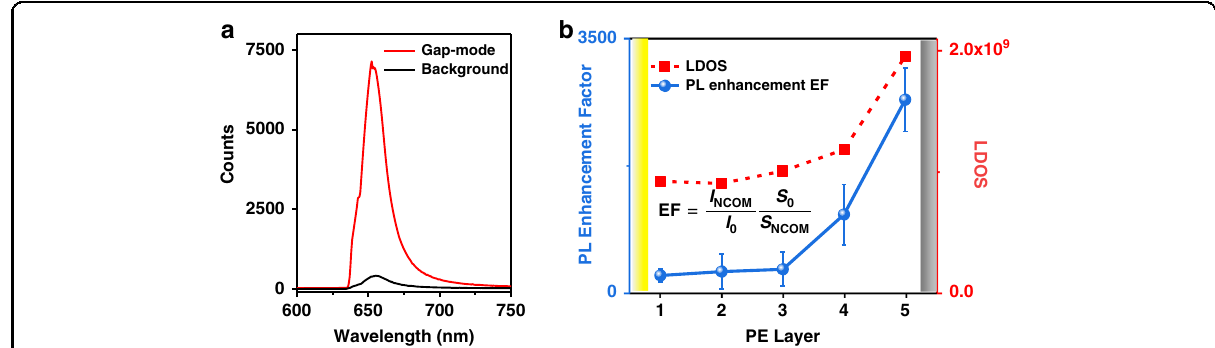
Fig. 4 The PL spectrum study of monolayer MoS 2 at the above gap-mode nanocavity with the same thickness of PE layers. a PL spectra of monolayer MoS 2 with (red) and without (black) gap-mode nanocavity. b The blue line is the enhancement factor of the PL at different positions; the red line is the LDOS at different